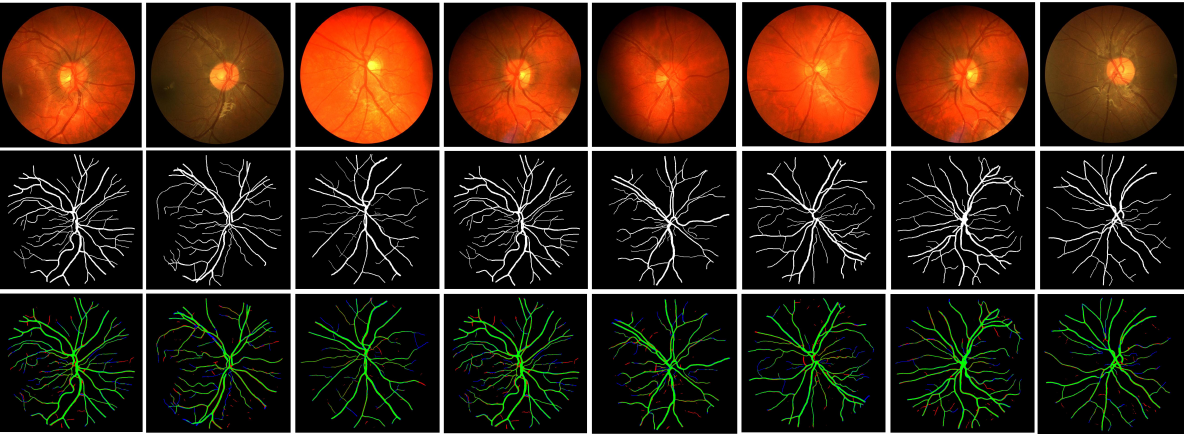
Figure 4. Analysis of segmented output. The segmentation maps’ black and green colours represent accurately predicted pixels, whereas the blue and red colours represent false negatives and false positives, respectively: in row one, noisy test images of CHASE dataset; in row two, corresponding ground truth images marked by 1st observer. In row three, the output of the proposed network is